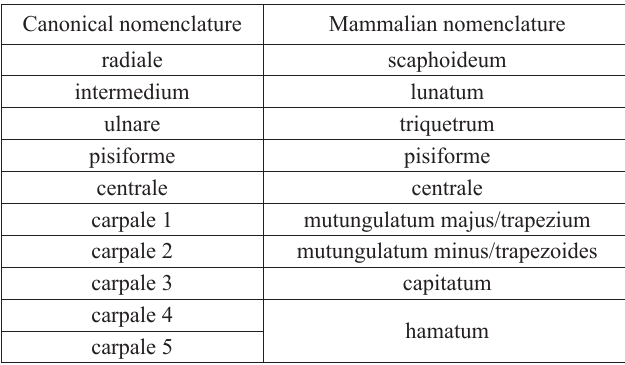
Table 1. Homology of the reptilian and mammalian carpals after Ge- genbaur